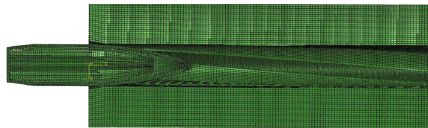
Figure 6: Mesh models of partial barrels and